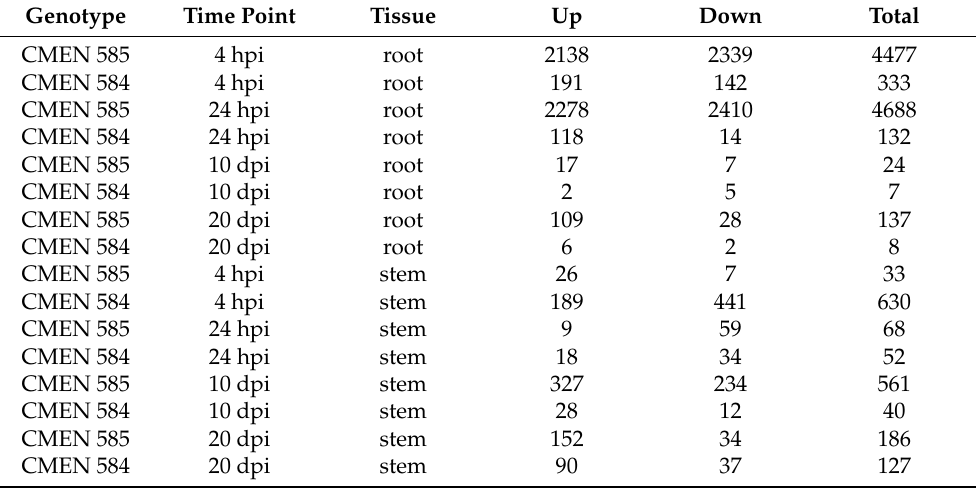
Table 1. Numbers of statistically significant differentially expressed genes for two M. longifolia genotypes sampled at time points from four hours to 20 days post-inoculation with Verticillium dahliae . ( p < 0.05, logFC >